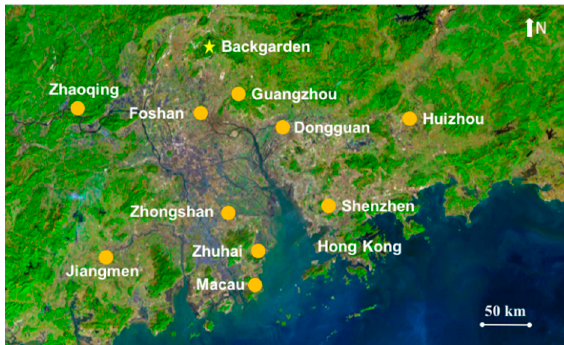
Figure 1. Location of the backgarden site and its surrounding areas in the Pearl River Delta Region.